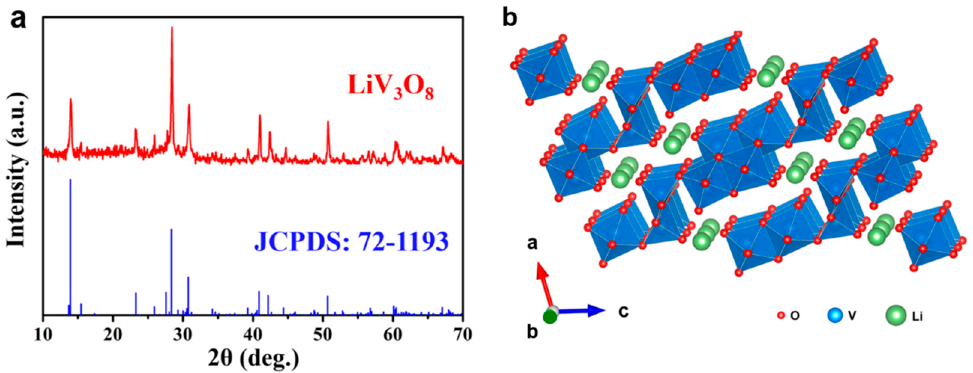
Figure 1. ( a ) XRD pattern and ( b ) structure model of LiV 3 O 8 .